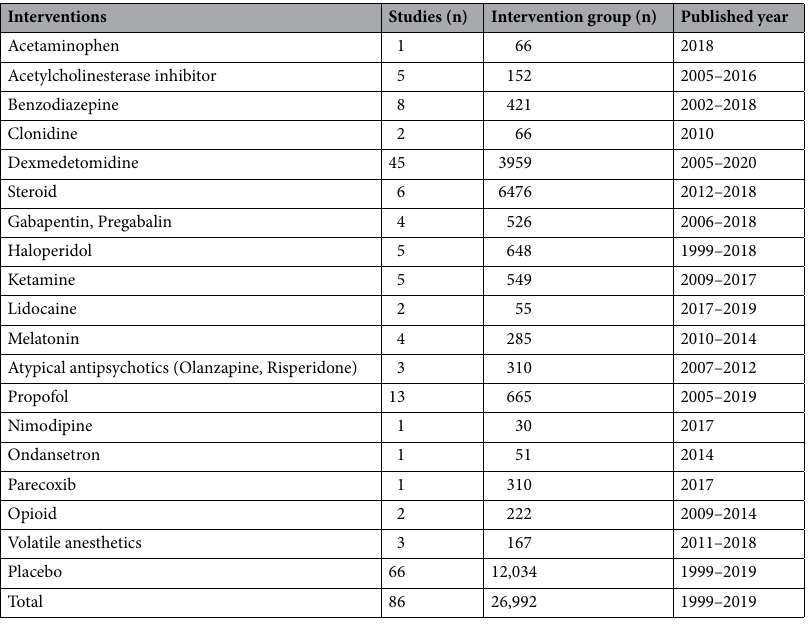
Table 1. Number of included studies and enrolled patients according to the individual interventions.